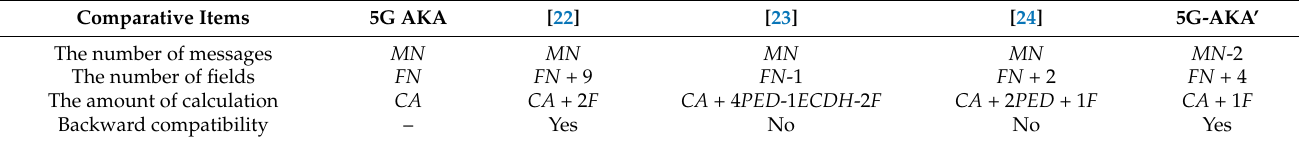
Table 3. The comparative analysis between the 5G-AKA’ protocol and some recently improved 5G AKA protocols [22–24] in the number of messages, the number of fields, the amount of calculation and backward